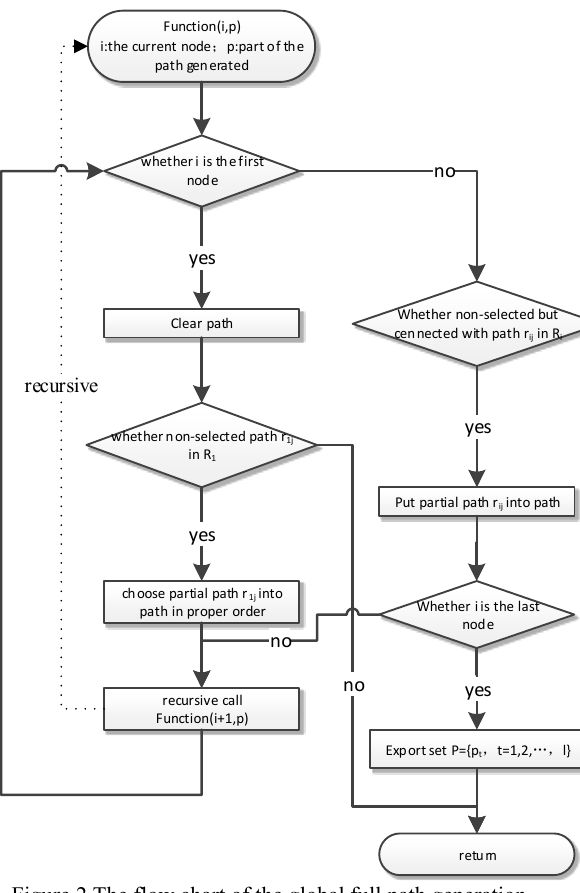
Figure 2 The flow chart of the global full path generation